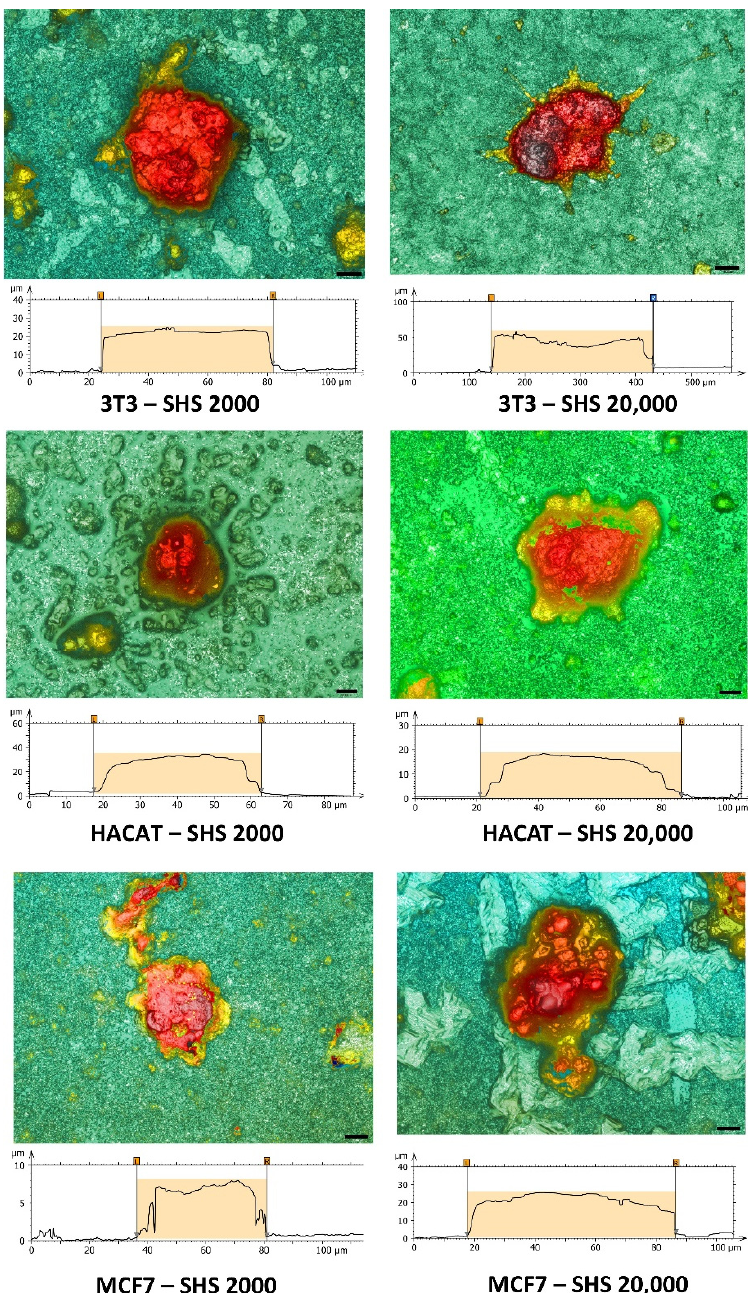
Figure 4. Representative 3D profilometry images in confocal mode (magnification 100 × ) of spheroids as a function of the initial cell density (either 2000 cell/ µ L or 20,000 cell/ µ L) after incubation in SH coating for 24 h, deduced by the corresponding profile sections.